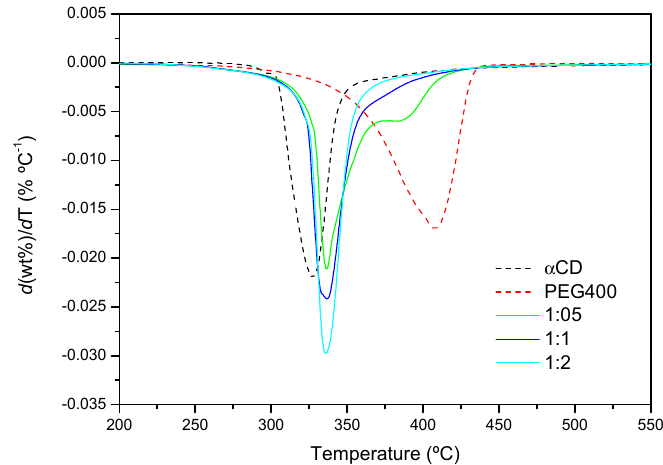
Figure 9. DTG curves of PEG400, α -CD and the products formed after the reaction for 24 h at 75 °C (1:0.5, 1:1 and 1:2 PEG400: α -CD molar ratios).